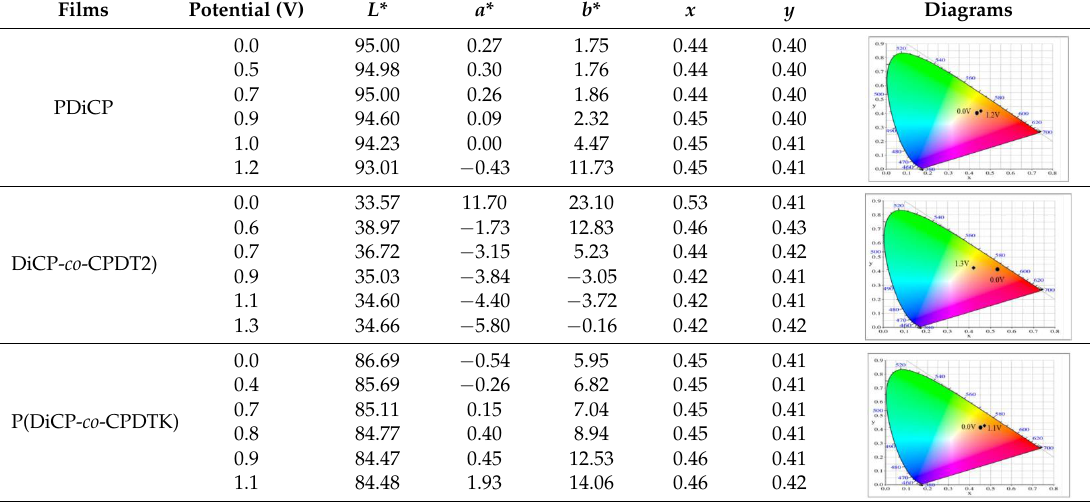
Table 2. Colorimetric values ( L *, a *, and b *), CIE chromaticity values ( x , y ), and CIE diagrams of (a) PDiCP, (b) P(DiCP- co -CPDT2), and (c) P(DiCP- co -CPDTK) films at various applied potentials. Films Diagrams Films